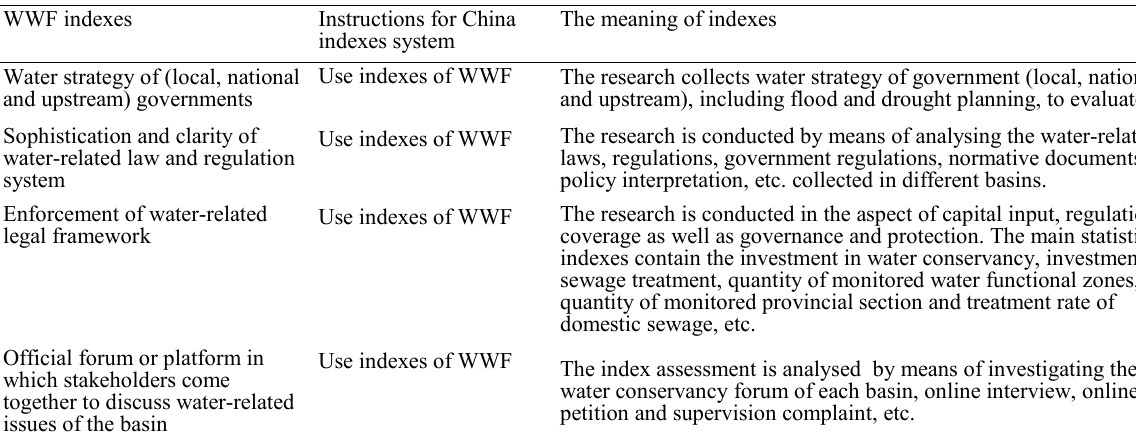
Table 2 Regulatory risk assessment